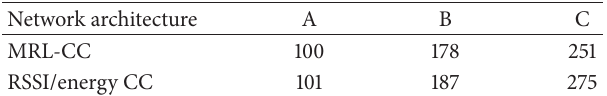
Table 3: Network lifetime (in days) till the WSN cannot transmit to the sink